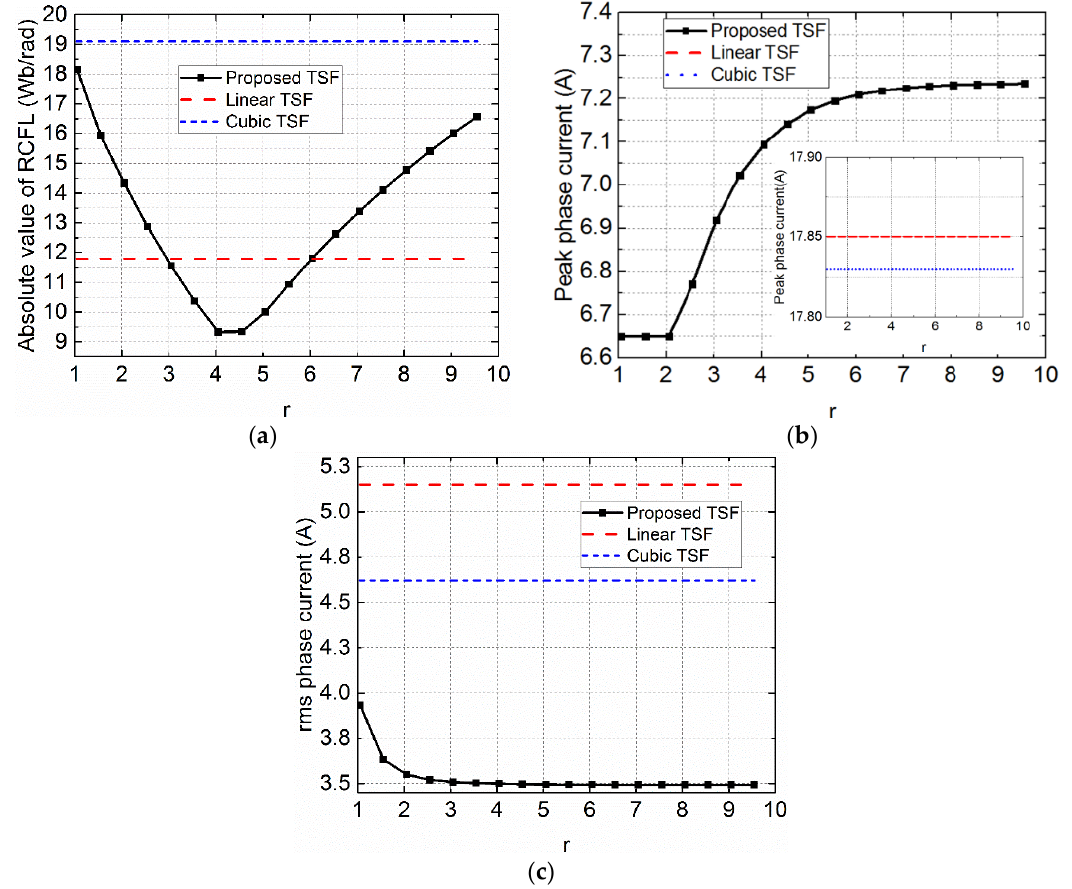
Figure 8. Comparison of the proposed TSFs: ( a ) absolute value of the RCFL; ( b ) peak phase currents; ( c ) rms phase currents.